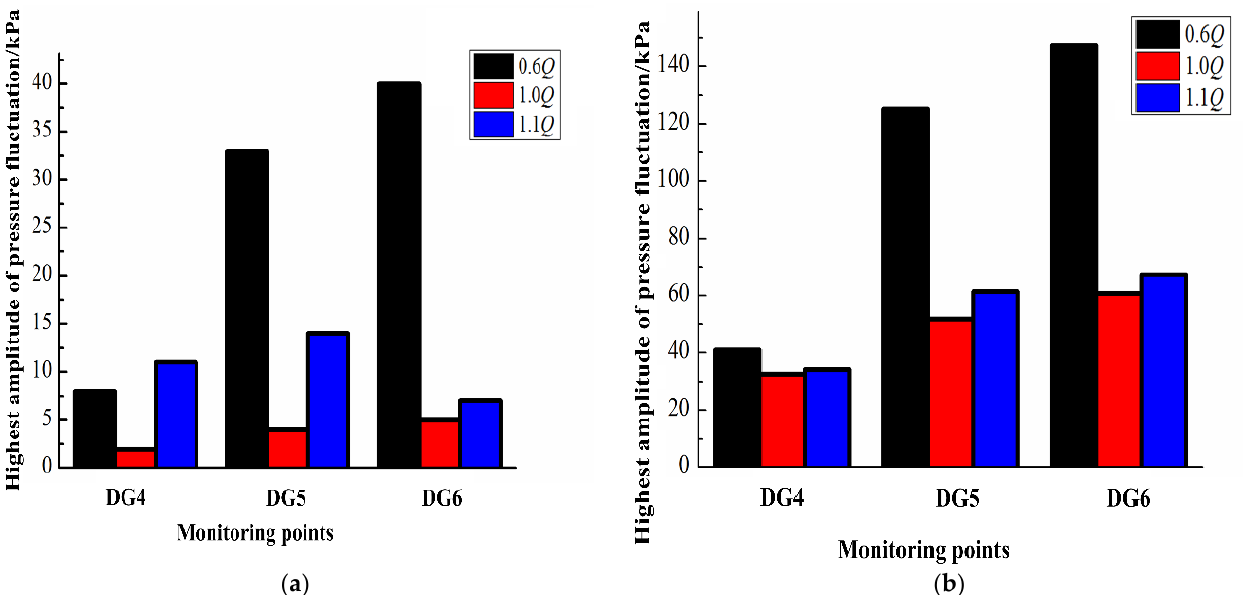
Figure 12. Highest amplitude of two single-suction impellers. ( a ) Single-suction impeller in refer- ence [36], ( b ) Single-suction impeller in this paper